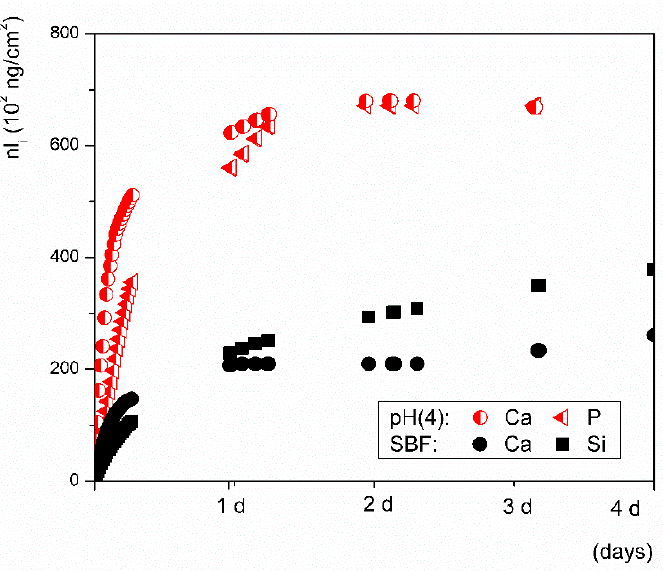
Figure 7. Ion release performance of Vitryxx glass in an aqueous solution at a pH of 4 when buffered with Ac/NaAc, nl(P and Ca) = f(t) (red triangles and circles), when compared to SBF nl(Ca and Si) = f(t) (black circles and squares).